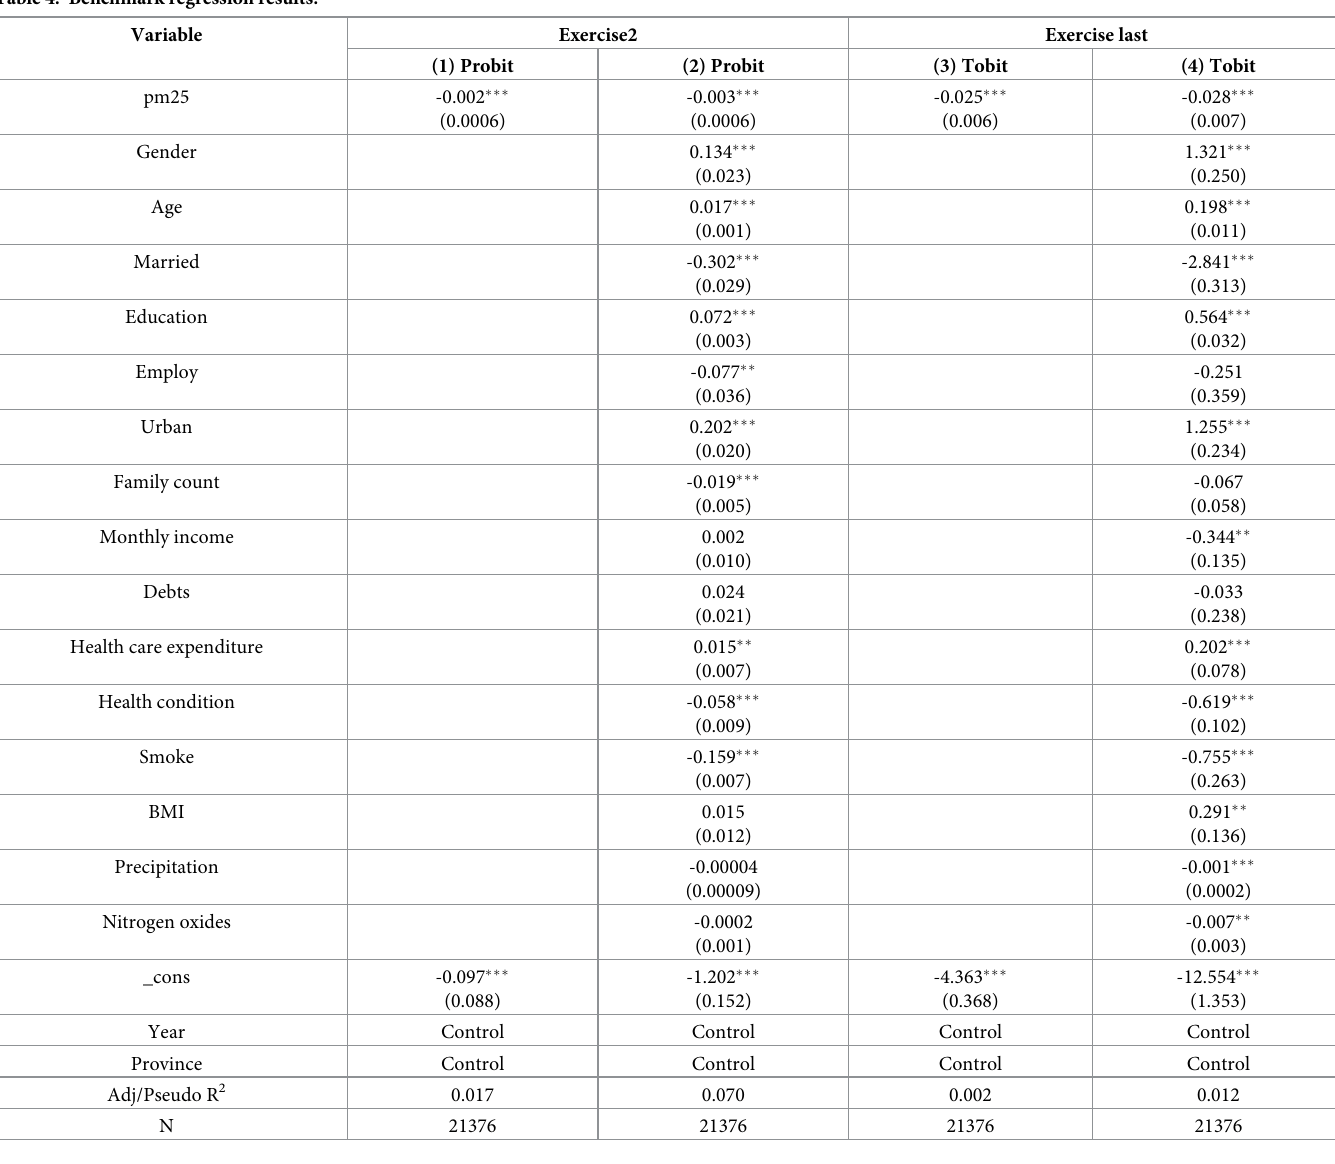
Table 4. Benchmark regression